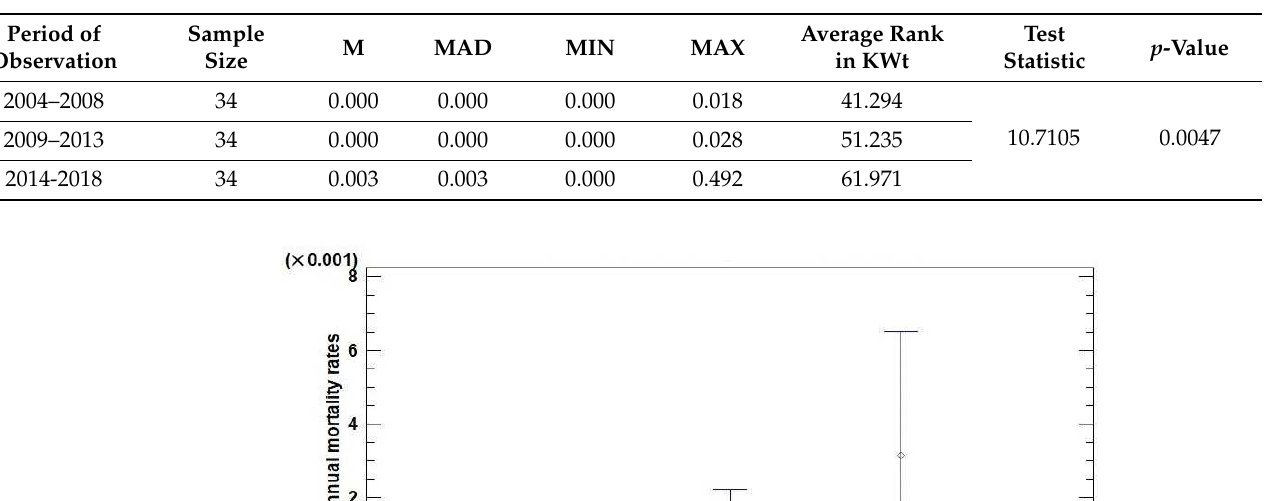
Table 1. Descriptive and nonparametric statistics for the annual mortality rates of trees monitored in the territory of Serbia for three observation periods. M—median; MAD—median absolute deviation; MIN—minimum value; MAX—maximum value; KWt—Kruskal-Wallis test.